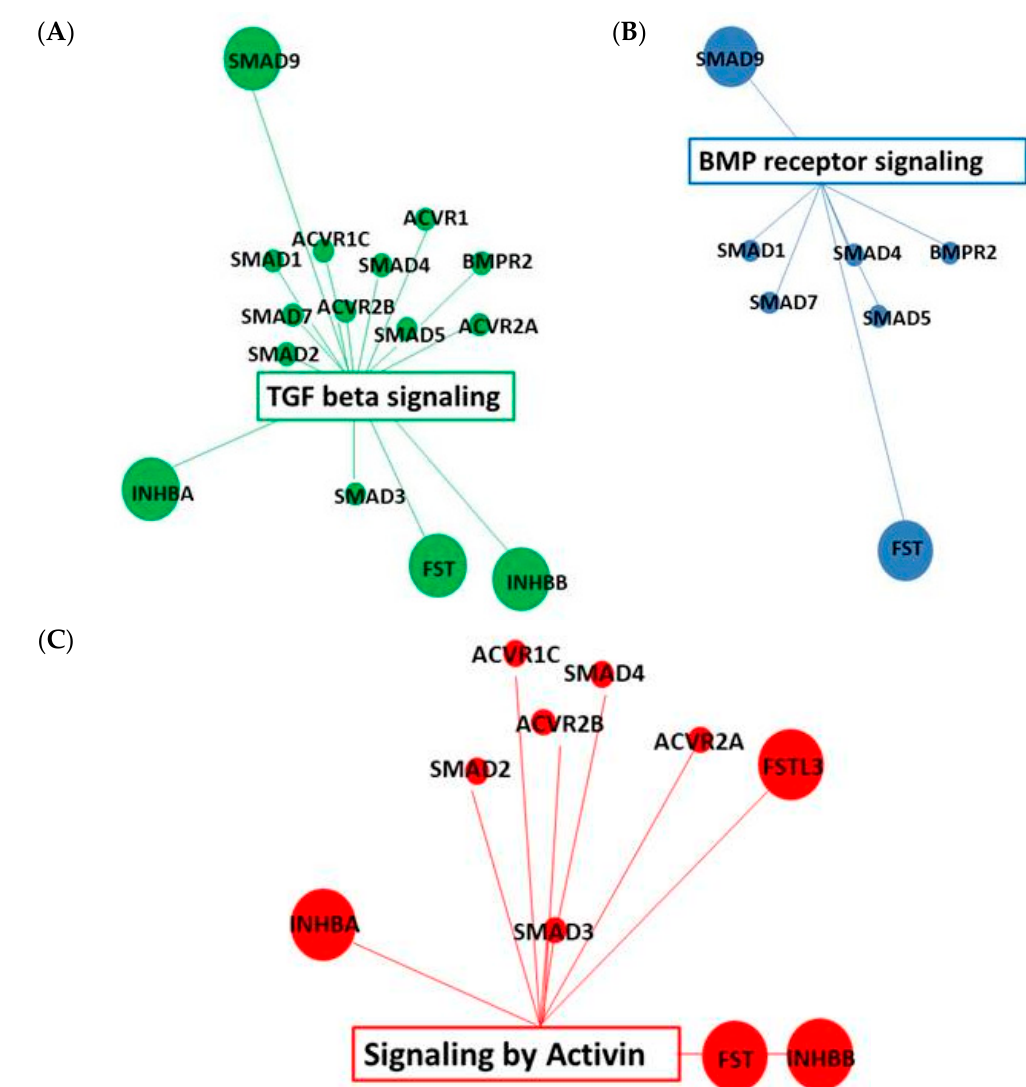
Figure 2. TGF-beta, BMP, and Activin signaling pathways are associated with upregulated genes by Activin-A. ( A ) Association with TGF-beta signaling pathway; ( B ) Association with BMP receptor signaling pathway. ( C ) Association with Activin signaling pathway. Pathway analysis on non-FDR-corrected differentially expressed genes with p < 0.01 performed with GeneMania (genemania.org, accessed on 21 September 2020). Figures are adjustments of the enrichment map of consolidated pathways ( C ), Boxed genes are genes from the input list; the other genes are relevant genes added by GeneMania. Size of the nodes is dependent on the number of interactions that gene has with the network. Table 1. GO terms associated with upregulated genes by Activin-A in FOP cells.